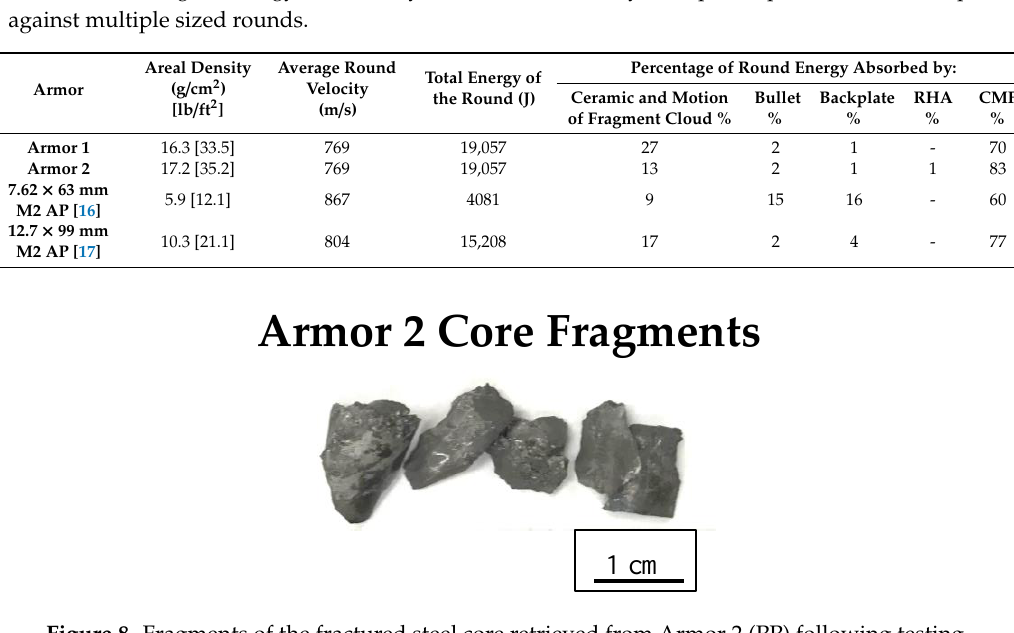
Table 3. Percentage of energy absorbed by a CMF armor each layer for partial penetration (PP) impacts against multiple sized rounds.